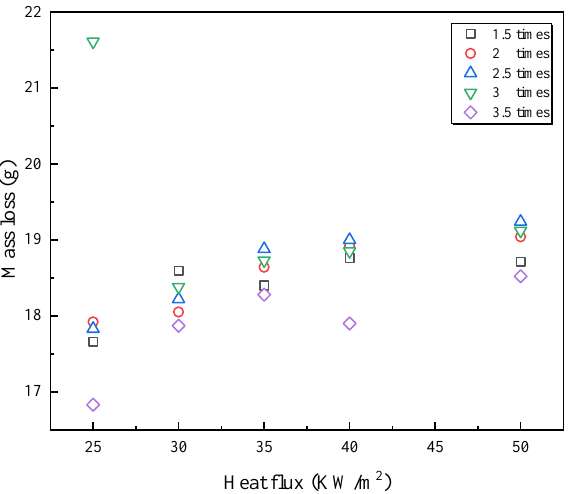
Figure 11. Mass loss under various heat flux and overload current conditions.